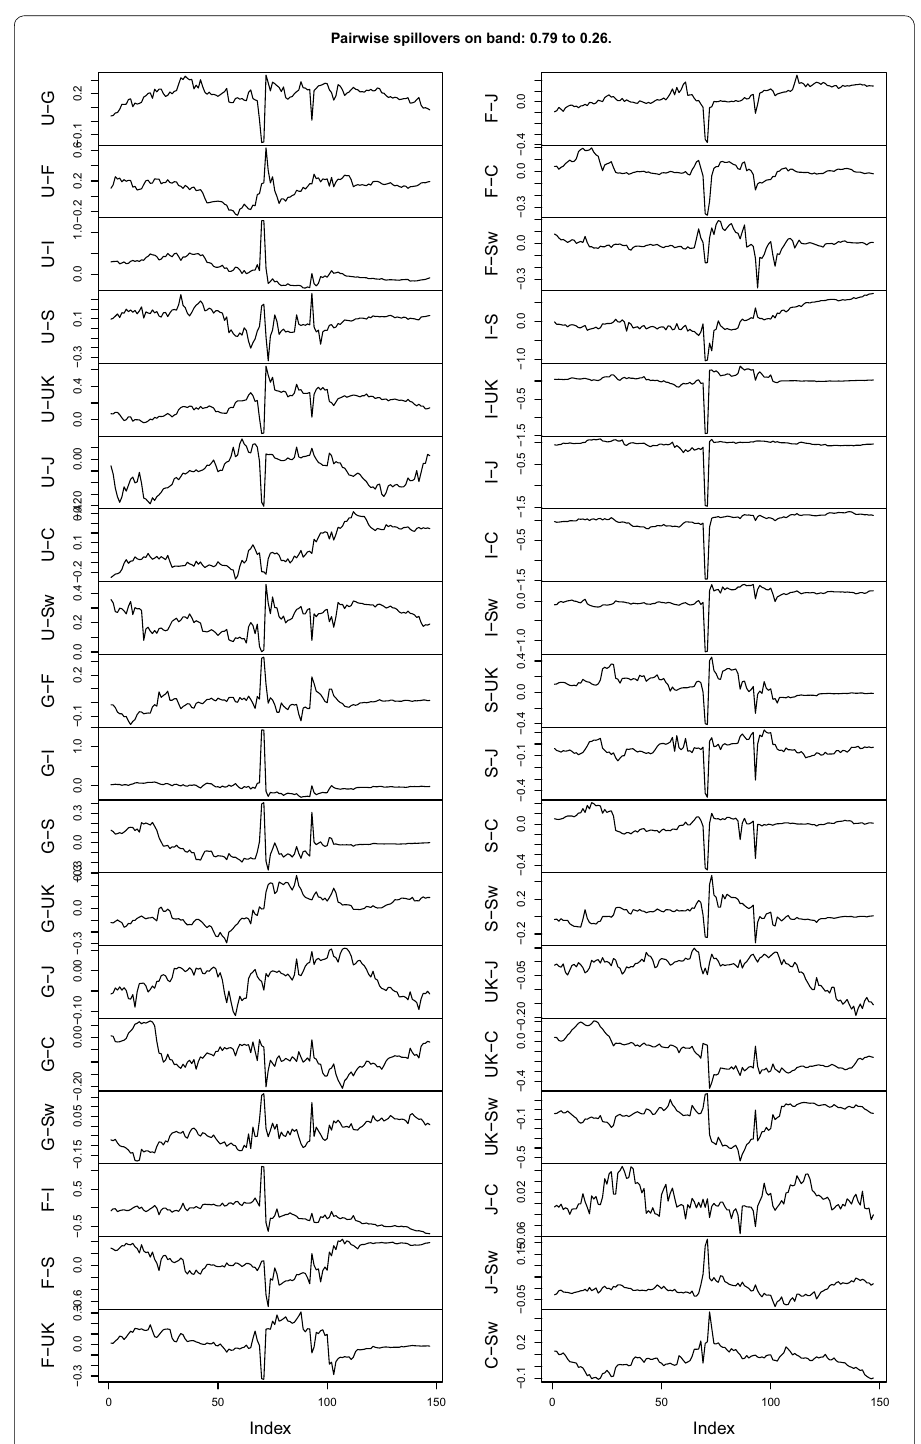
Fig. 11 10y3m—BK 4 to 12